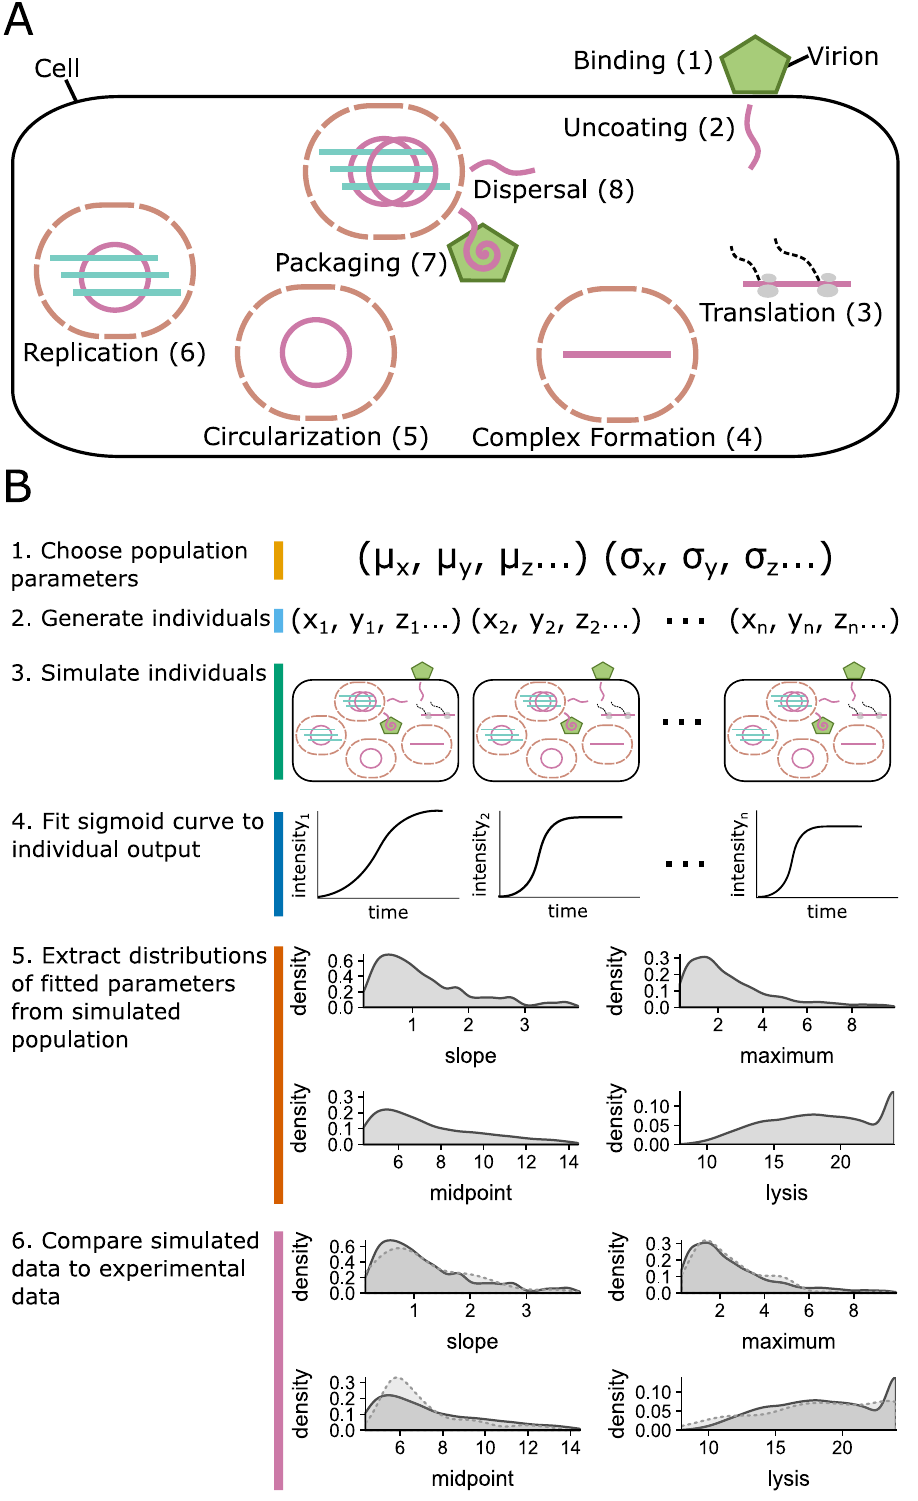
Figure 2. Illustration of PV replication cycle and parameter estimation procedure. ( A ) The replication cycle of PV as represented in the model of Schulte et al. 23 . This figure is adapted from that work. Numbered steps correspond to individually modeled reactions given in Table 1. ( B ) Computational procedure to compare the output of the mechanistic model of a single PV infection to the experimental data obtained from populations of single-cell